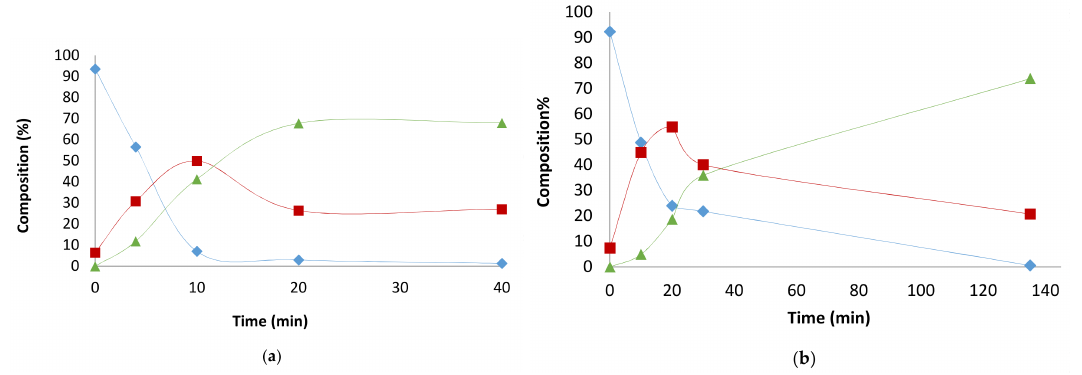
Figure A4. Composition profiles as a function of time at [ 1 ] 0 /[Rh] = 3000: ( a ) acetonitrile; and